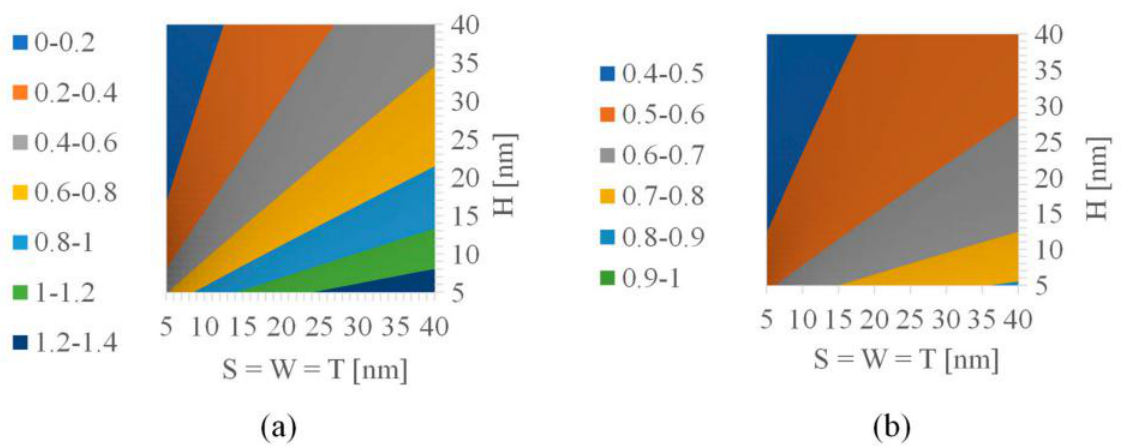
Figure 5. ( a ) H vs. C V and ( b ) W (= S = T ) vs. C HV in case the number of wires is three.